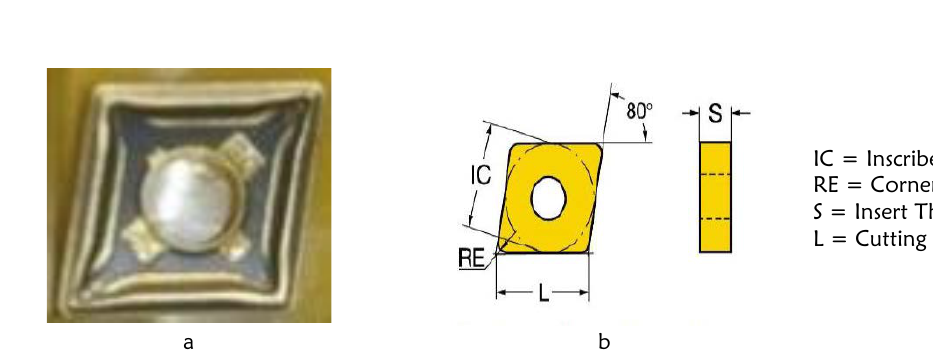
Figure 1: (a) Ti6Al4V implant (b) Schematic for specimen (Ti-6Al-4V)